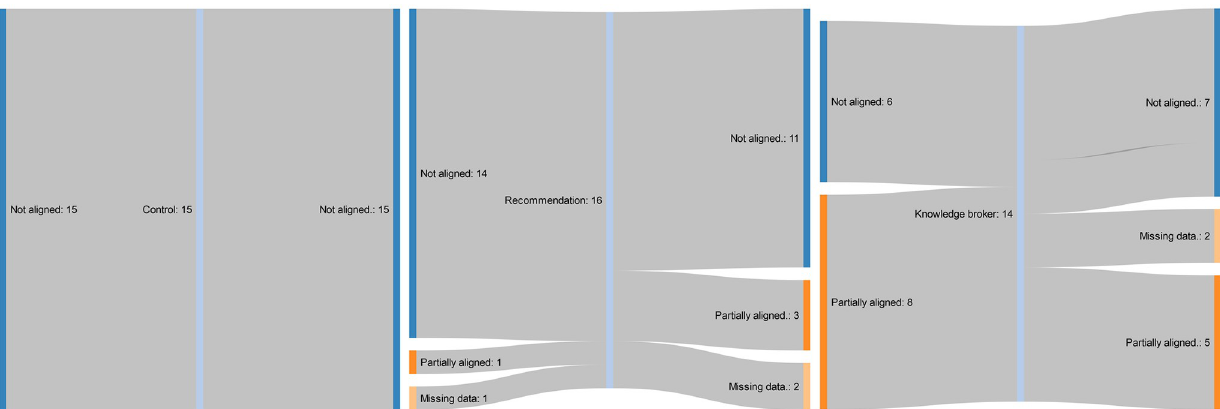
Fig 2. Flow of clusters from baseline to follow-up policy recommendations alignment, by implementation strategy group.